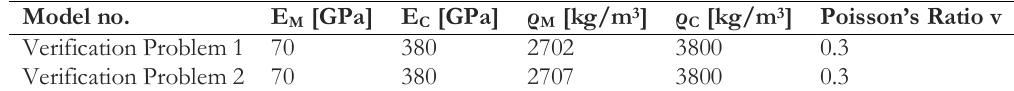
Table 2. Material properties for verification problems 1 and 2.